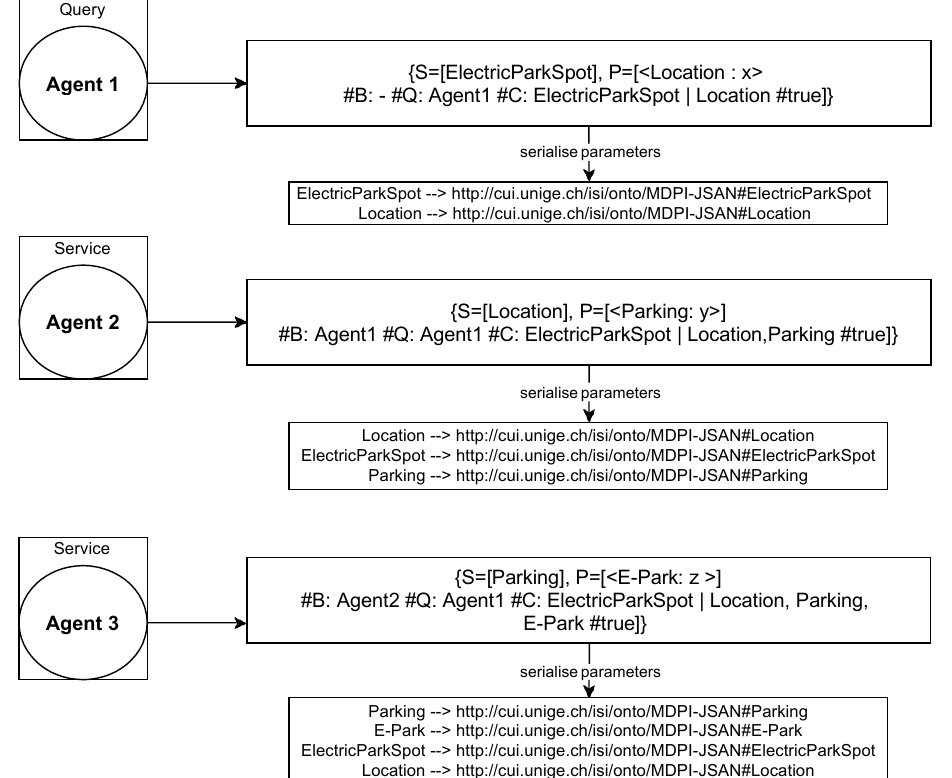
Figure 8. URIs generation of the services/queries parameters used in the semantic matching process by the Apache Jena rules engine-electric car parking